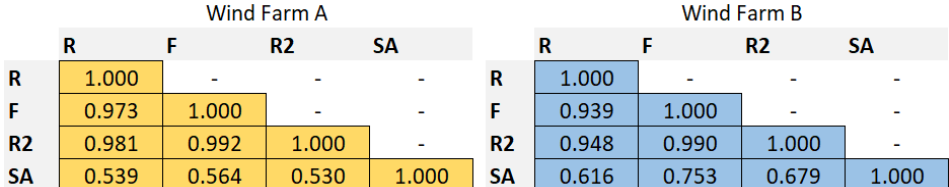
Figure 10. Results of sensitivity analysis of potential input variables for prediction models for Wind Farm A and Wind Farm B: 4 analysis methods and final Overall Rating (OR).